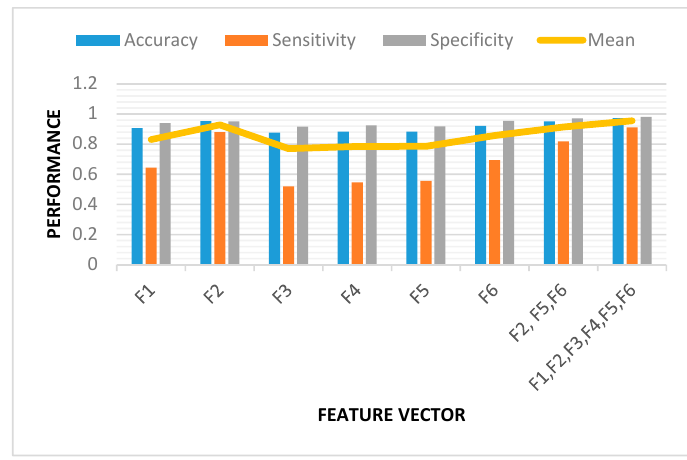
Figure 13. Feature validation for VF detection algorithm based on the unbalanced BDT classifier. The mean is the average of accuracy, sensitivity, and specificity values for each of the feature vectors.